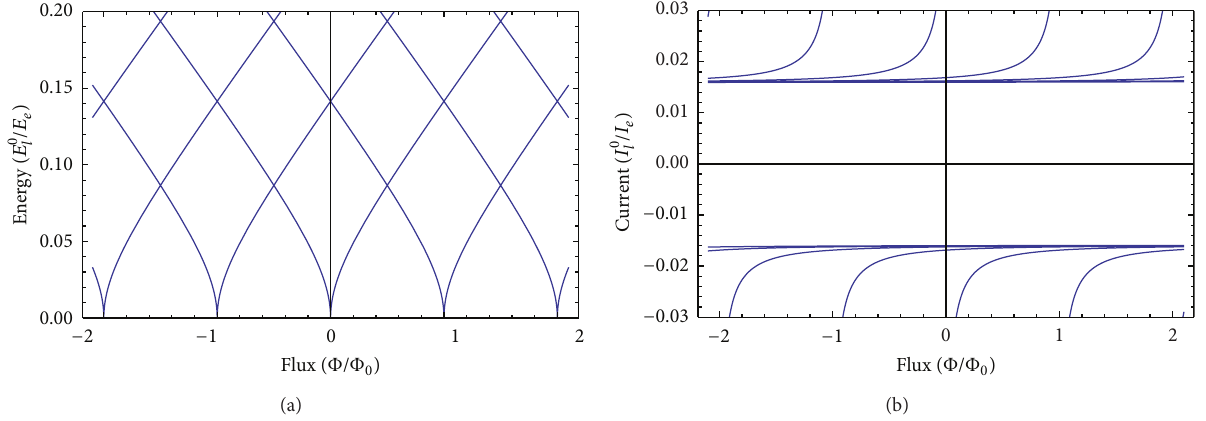
Figure 5: Nature of energy and current for massless particles. The lower cutoff value for current is given by 𝑒𝑐/2𝜋𝑅 . Here we used 𝑅 = 10𝑟 𝑒 with the same units as in Figures 2 and